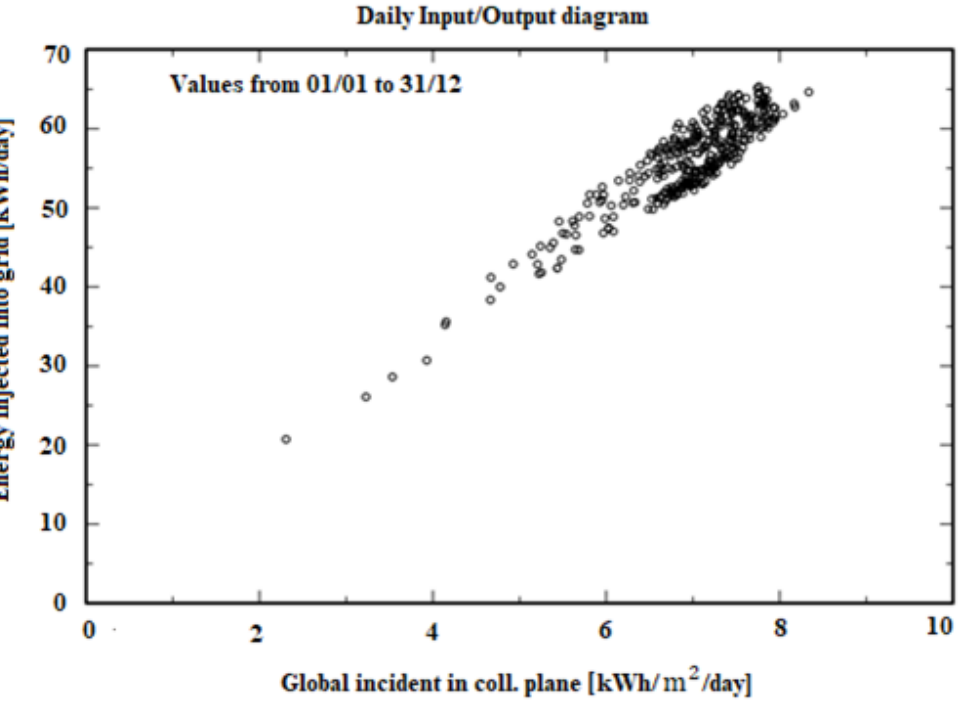
Figure 6. Daily input/output diagram for the Darab area.